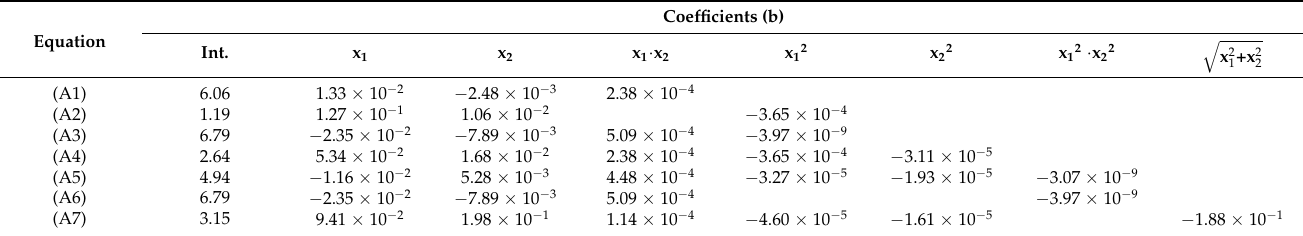
Table A2. Intercepts and coefficients associated to x 1 and x 2 (radial and longitudinal directions) for each model of regression indicated with the number of equation